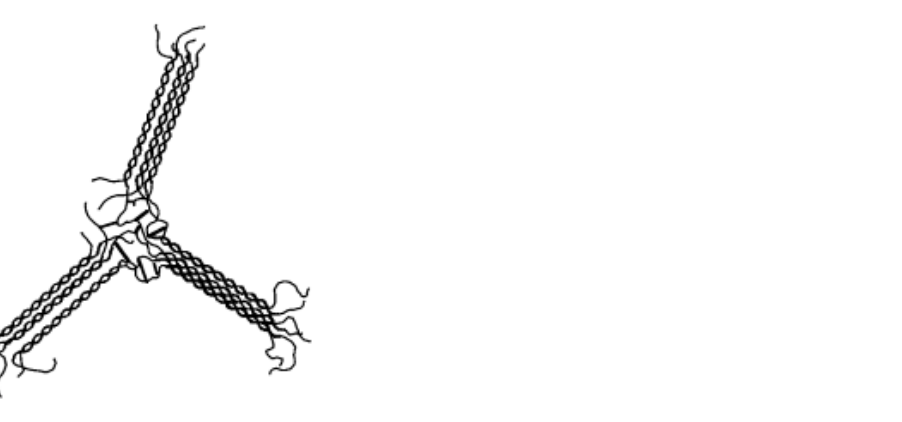
Figure 8. Schematic view of self-cross-linked gellan network structure, where heavy solid lines represent crosslinking points. Reprinted with permission from [95]. Copyright 2022, American Chemical Society